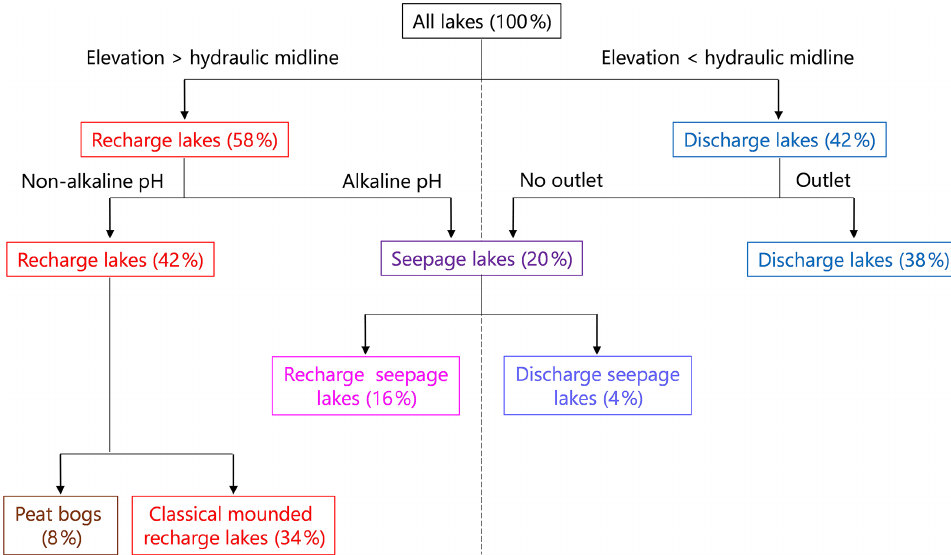
Figure 7. Illustration of a novel lake typology for the study lakes. Lake elevation was used as the primary factor in separating lakes, with elevation being an effective surrogate for dividing lakes based on the contribution of groundwater flow to a lake. The lakes were then separated based on the presence of an outlet as well as lake-water pH and other morphological characteristics of the